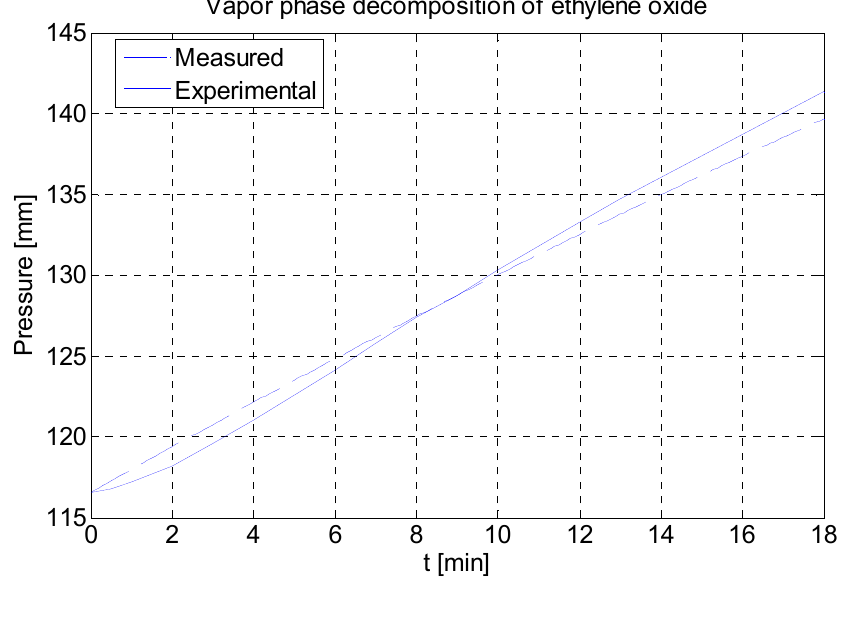
Figure 8. Vapor phase decomposition of ethylene oxide. A comparison between experimental data and simulation results acquired using the analogous electrical